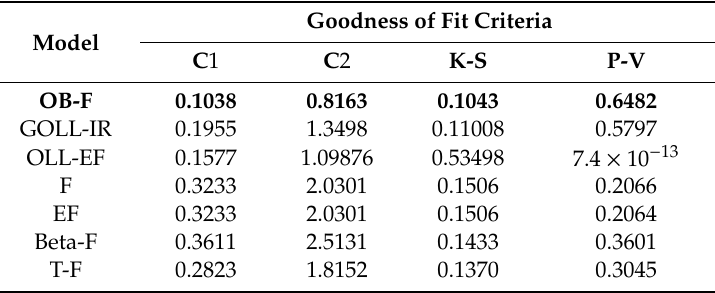
Table 12. MLEs and their standard errors (in parentheses) for data set III. Model